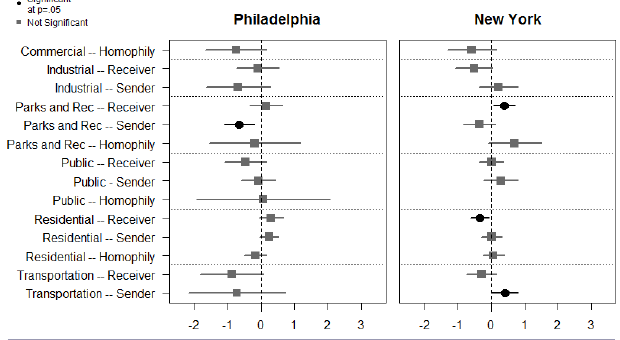
Fig. 8 . Odds ratios for Census block land use exponential random graph (ERG) terms for Philadelphia and New York City ERG